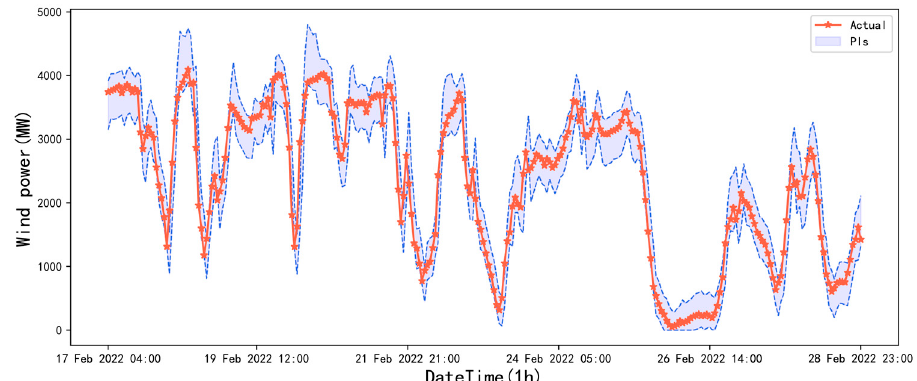
Figure 12. Plot of the prediction intervals of the ERNN-based model.